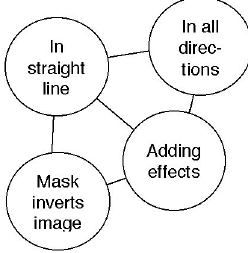
FIG. 6. Resource graph for incorrect response. This student did not delete one resource but